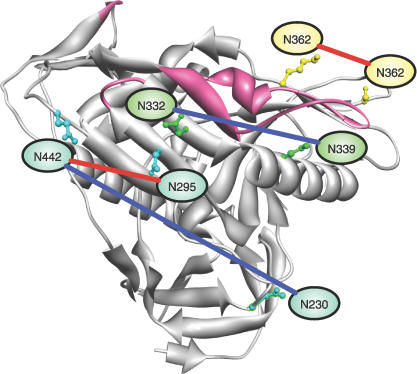
Interacting PNGS Mapped to Structural Model of gp120Arcs from the consensus network are mapped to asparagine residues in the structure of a folded CD4-bound gp120 protein. The host cell-binding face of gp120 is oriented towards the top of the figure, and variable loops (of which many residues are truncated) are highlighted in pink. Arcs are colored red to indicate mutual exclusion, and blue indicates co-occurrence of the PNGSs. The asparagine residues of mutually exclusive PNGSs N295/N442 and N362/N465 are located within ∼12 Å of one another. In contrast, co-occurent PNGSs are separated by much greater intramolecular distances.